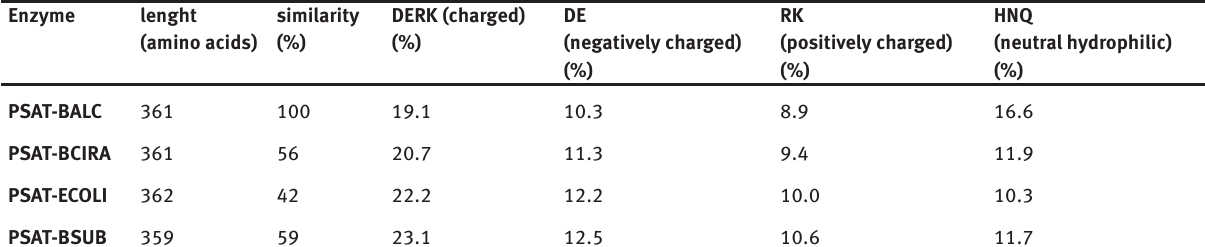
Table 4 : Amino acid analysis of PSAT-BALC, PSAT-BCIRA, PSAT-ECOLI, and PSAT from B. subtilis. Structural alignment was done with SwissProt. Abbreviations: D, aspartic acid; E, glutamic acid; H, histidine; K, lysine; N, asparagine; R, arginine; and Q, glutamine. Enzyme lenght (amino